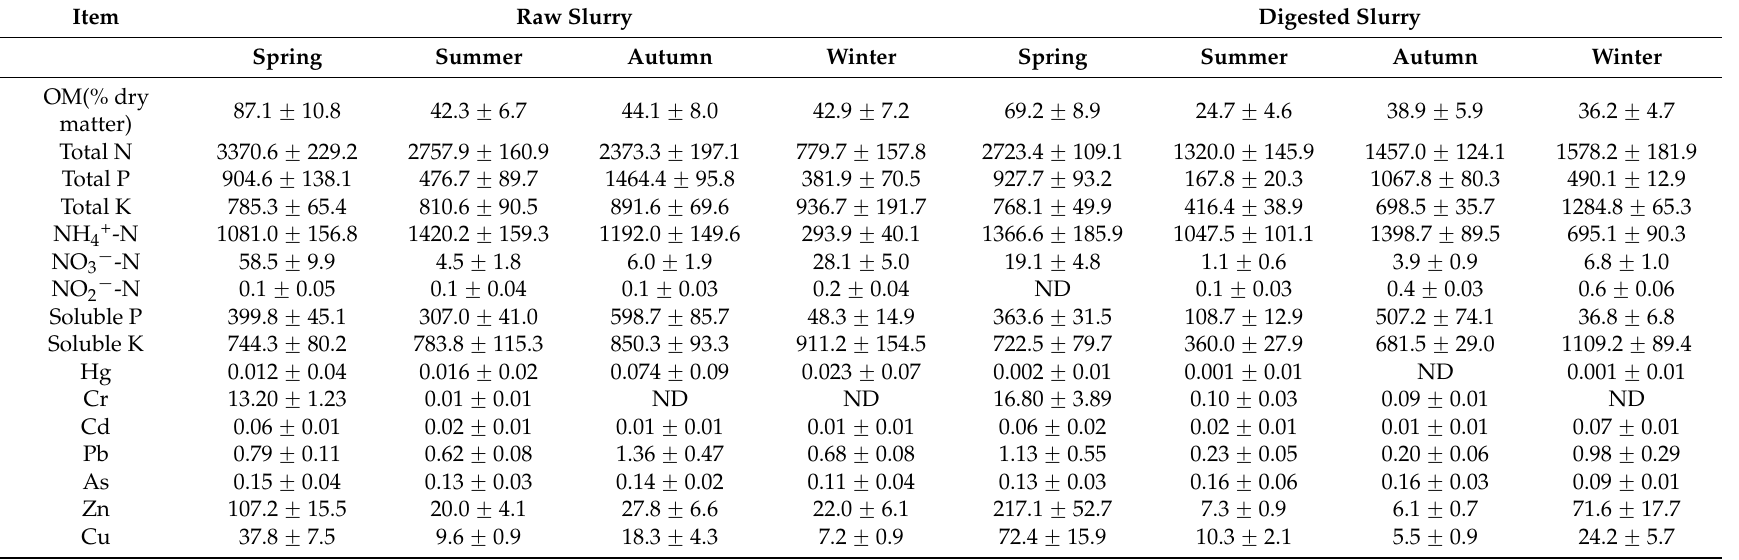
Table 1. Nutrients and heavy metals contents in digested and raw pig slurries in different seasons (unit: mg ¨ L ´ 1 unless